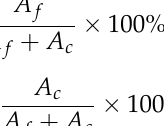
Figure 6. Graph of the percentage of free ions and contact ions for AMg25, AMg30 and AMg35 polymer electrolytes.